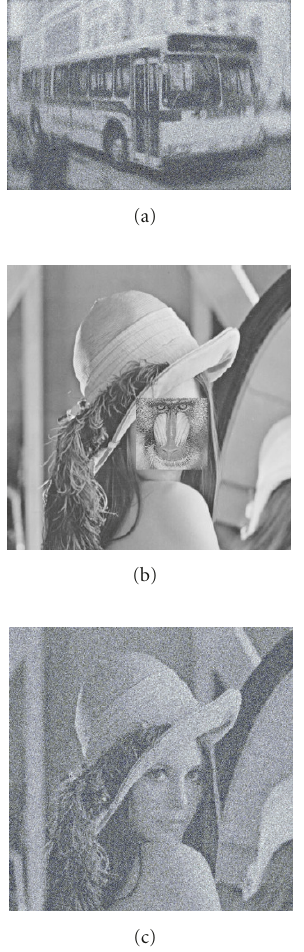
Figure 8: (a) Unintentional tampering: decrypted result of unreg- istered shares; (b) intentional tampering: Lena masked; (c) decryp- tion using 40 shares resists tampering and discloses Lena’s face.